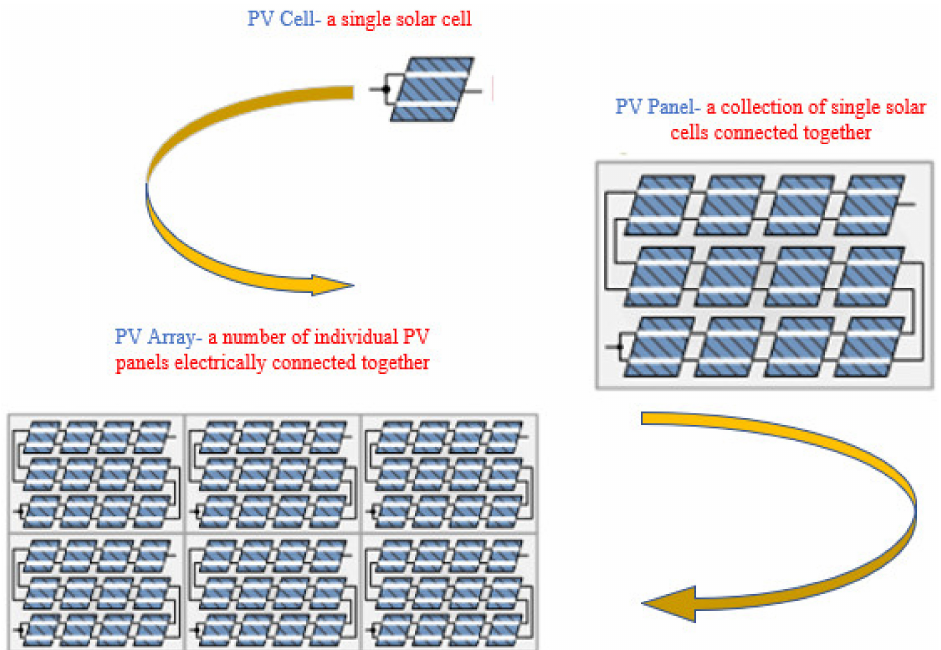
Figure 5. PV cell, PV Panel, and PV array.